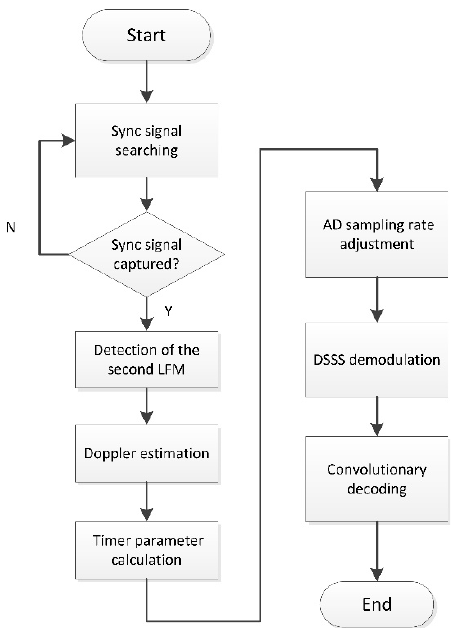
Figure 4. Illustration of the demodulation processing of the receiver.